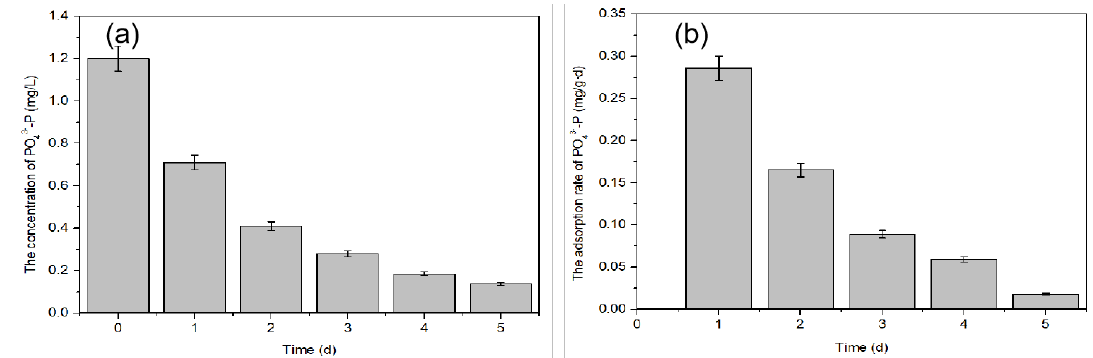
Figure 6. Changes of PO 43 − concentration and absorption rate. ( a ) Changes of PO 43 − concentration in culture medium, ( b ) Changes of PO 43 − absorption rate by water spinach.